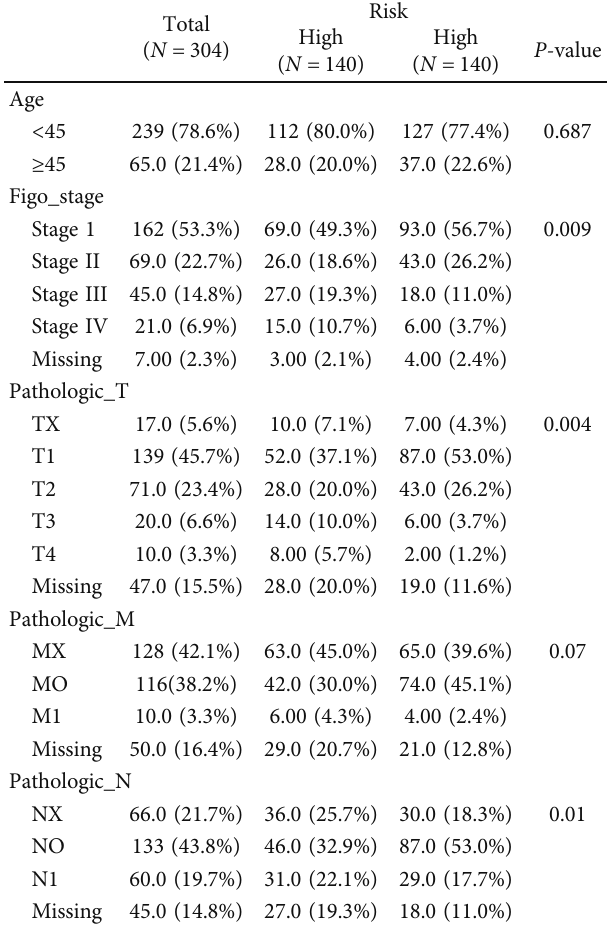
Table 3: Association of risk score and clinical